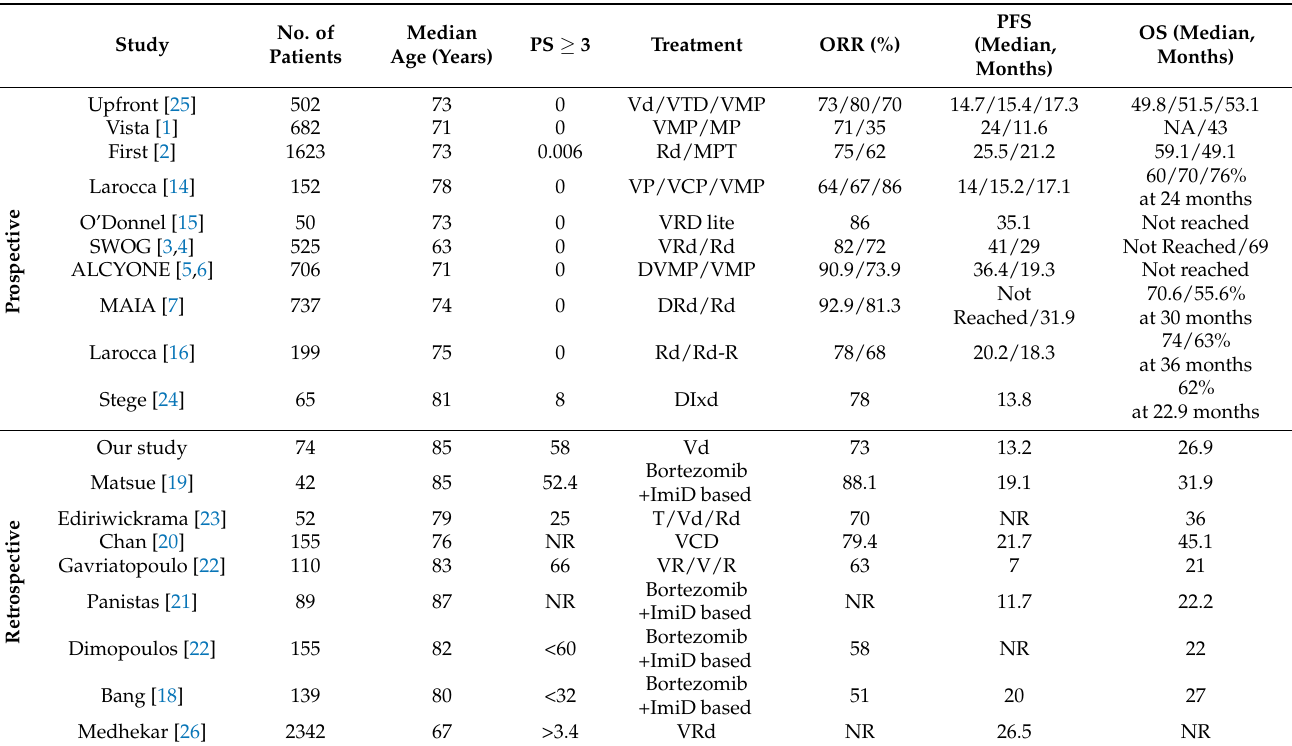
Table 5. Summary of data from prospective and retrospective studies focusing on elderly patients with NDMM. NR: Not Reported; Vd: Bortezomib + low dose dexamethasone; VMP: Bortezomib Melphalan Prednisone; MP: Melphalan Prednisone; Rd: Lenalidomide dexamethasone; MPT: